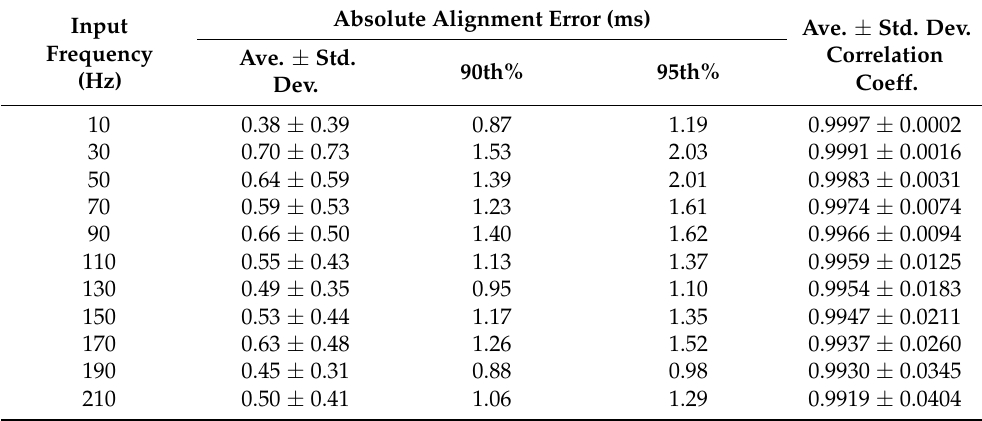
Table 1. Summary of absolute alignment errors and correlation coefficients of simple data alignment (SDA) algorithm as a function of input sine wave frequency.